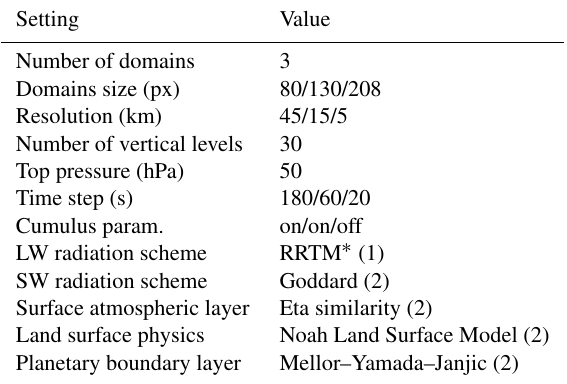
Table 1. WRF settings used for the simulations. The number in parentheses indicates the scheme number (option) in the WRF set-